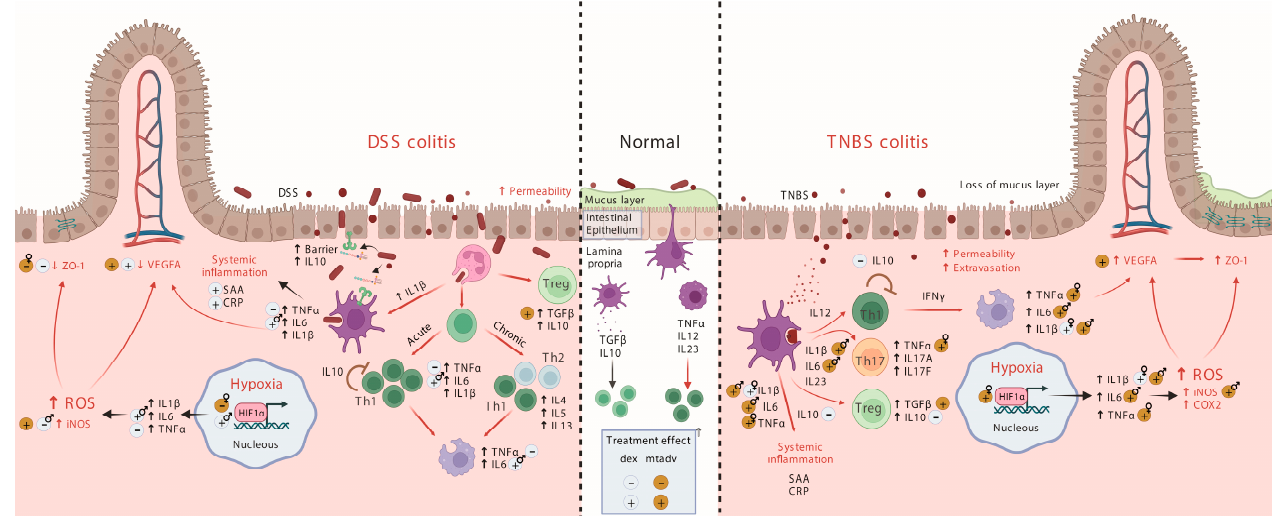
Figure 6. Representation of the inflammatory process induced in the colonic mucosa of both TNBS and DSS models. TNBS changes the conformation of antigens in the colonic mucosa, making it alien to the host immune system and thereby initiating transmural colitis. Dendritic cells recognizing these antigens drive the inflammatory process to Th1 and Th17 phenotypes which are also charac ‐ terized by infiltration of the lamina propria with CD4+ T cells, neutrophils, and macrophages by the systemic production of APPs. It also drives T ‐ cell differentiation to the T ‐ reg phenotype but shows a more pronounced increment of pro ‐ inflammatory cells. The hypoxic environment and macro ‐ phages activated by Th1 cells promote angiogenesis and mucosal immune barrier reparation (tight junctions) [21]. DSS causes disruption of the intestinal epithelial barrier and, thereby, the entry of luminal bacteria or bacterial antigens into the mucosa. Neutrophil and dendritic cell detection of PAMPs by TLR, among others, provoke the start of inflammation, characterized by a Th1 phenotype in acute models and a mix of both Th1 and Th2 in chronic colitis. Altogether, this increases the pro ‐ duction of APPs and decreases angiogenesis and mucins and tight junction protein expression with an imbalance between pro ‐ inflammatory and anti ‐ inflammatory cytokines [21]. Created with BioRen ‐ der.com. APP, acute phase protein; PAMP, pathogen ‐ associated molecular pattern; T helper cells; TLR, toll ‐ like receptor; TNBS, trinitrobenzenesulfonic acid, T ‐ reg, T regulatory cells. In DSS ‐ induced intestinal inflammation, mucosal Il6 and plasmatic SAA correlated positively with BLI, while Tgfb1 correlated negatively in the therapeutic approach. On the other hand, both BLI and Nos2 correlated negatively with reparative Tjp1 and Vegfa ex ‐ pression, mainly in females. In contrast, in the preventive trial, cytokine correlations were similar to those in the TNBS and mainly influenced by males. Here, there was also a neg ‐ ative correlation between Il6 and BLI, suggesting a certain immunosuppressive effect in this acute inflammatory stage. This contrasts with the therapeutic model, in which repar ‐ atory processes were the protagonists. DSS ‐ induced barrier weakness causes bacterial translocation, which activates functions driven by toll ‐ like receptors in both epithelial cells and neutrophils [21]. Among these is the synthesis of NFkB ‐ induced cytokines, but also